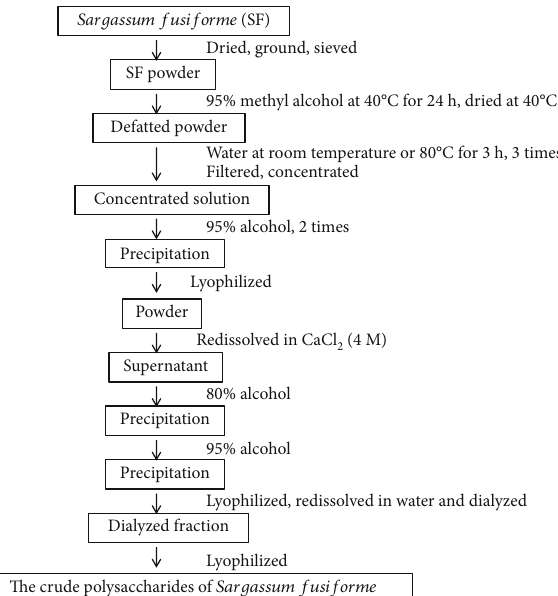
Figure 1: The fl owchart of the extraction of the crude polysaccharides from Sargassum fusiforme